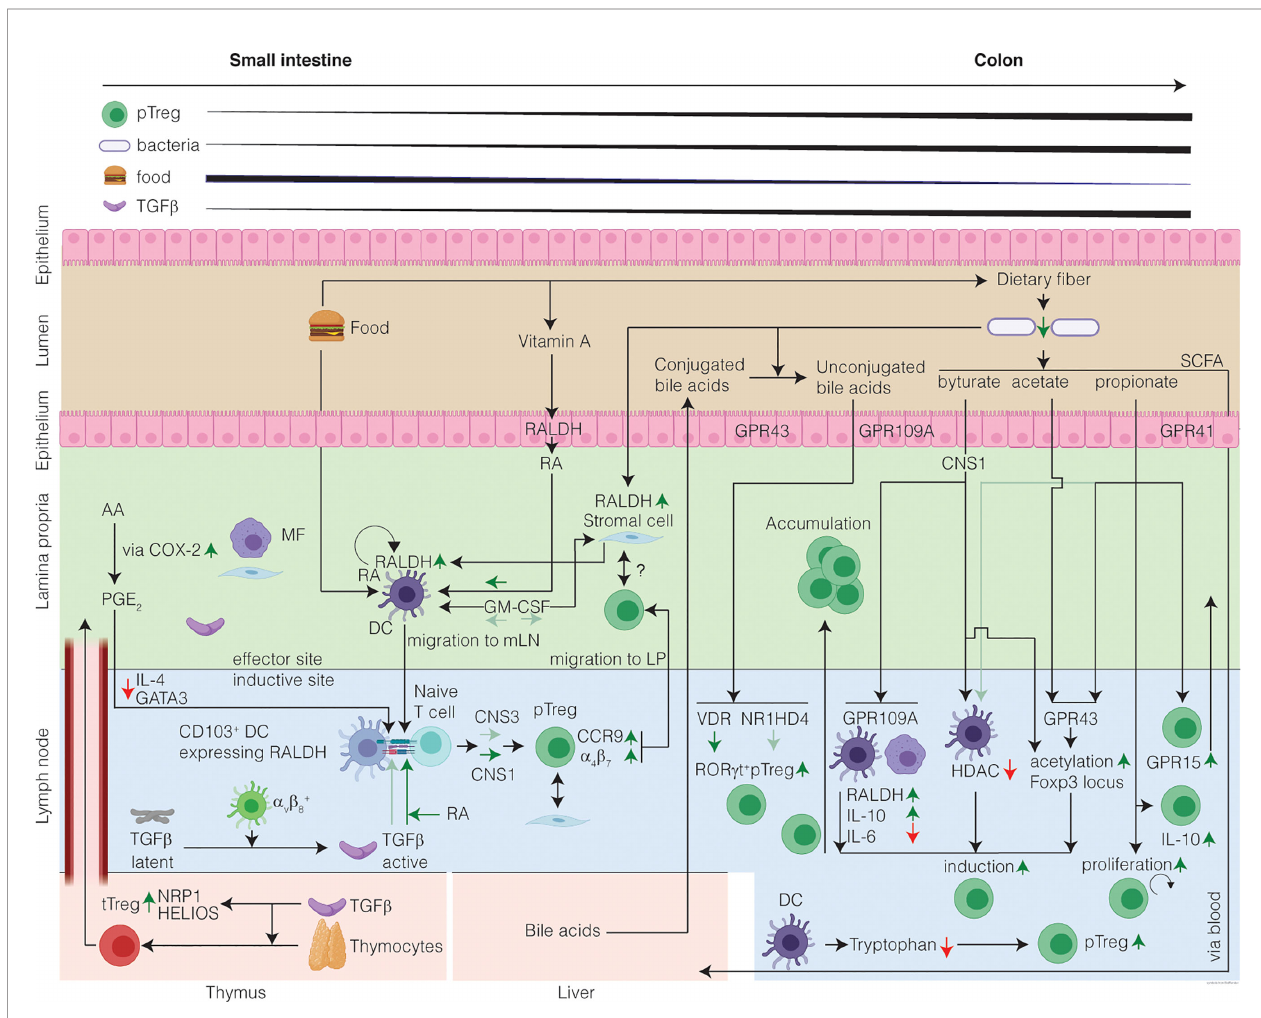
FIGURE 1 | The healthy intestine favors Treg-cell induction in response to harmless antigen and local microenvironmental conditioning maintains the Treg cell phenotype. The mechanisms of intestinal Treg cell induction depend on the structure of the encountered antigen and on the inductive site: in the SI encounter of harmless food antigens predominates eliciting DC-mediated Treg cell induction from naïve T cells. In the colon, commensal microbiota produce SCFA which in presence of TGF b induce ROR g t + Treg cells. In the SI inductive sites, DC-derived TGF b induction converts circulating naïve T cells into pTreg cells, which is further potentiated by diet-derived RA. Treg cell induction in the SI is CNS1-dependent with a minor contribution from CNS3. In the colon inductive sites, the SCFA induce Treg cells. SCFA induce acetylation of the Foxp3 locus and alter the phenotype of the pTreg cells by increasing ROR g t. Moreover, bile acids unconjugated by the microbiome contribute to the induction of colonic ROR g t + Treg cells. After induction, pTreg cells migrate from the inductive sites to the LP, where they accumulate and maintain immune homeostasis. In the LP, Treg cells might interact with stromal cells, which receive signals from the microbiome, through a cell- contact dependent mechanism. A portion of the intestinal Treg cells is tTreg cells, induced in the thymus in presence of TGF b , and that have migrated to the intestine and are highly expressing putative markers for tTreg cells. Finally, a gradient of Treg cells exists increasing from SI to colon. Question marks indicate research areas that remain relatively